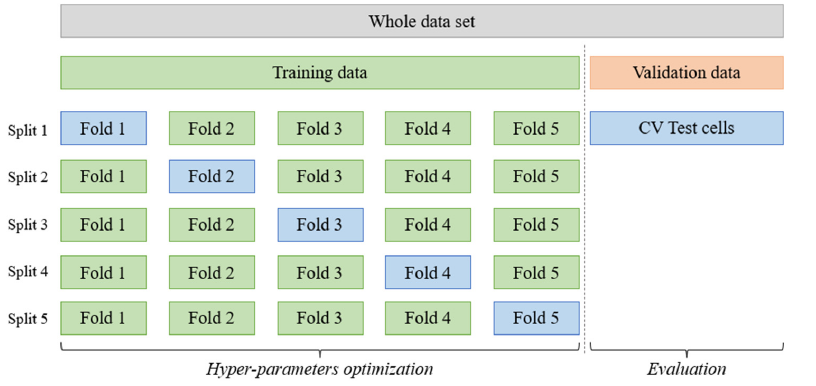
Figure 2. Five-fold Cross Validation, where each fold coincides with an available year. The green color represents the subdivisions for model training, while the blue color represents the test subsets. The validation set is orange in color [24].